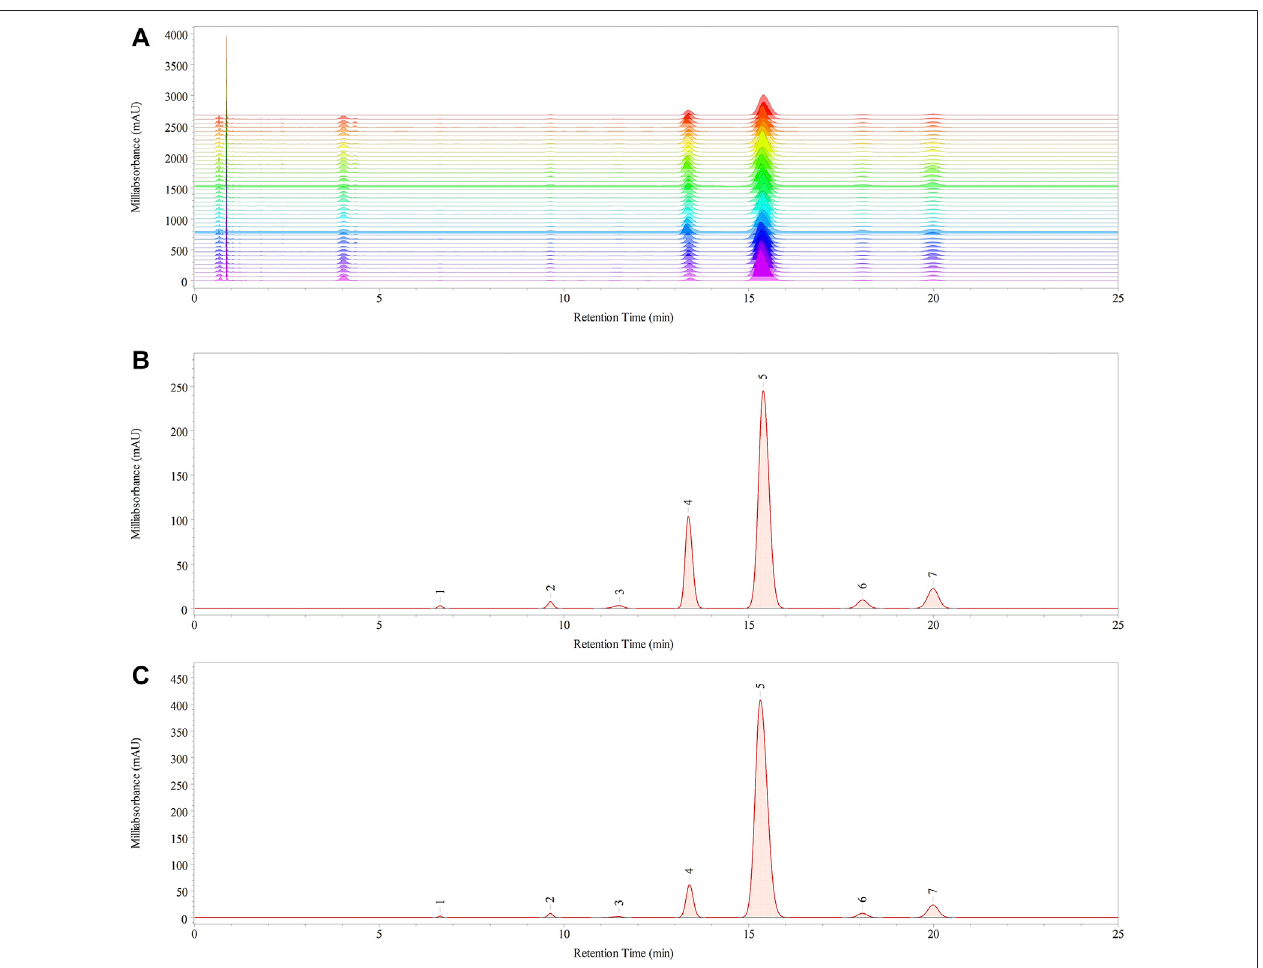
FIGURE 3 | The chromatograms of 40 polysaccharide samples (A) PCD-UPLC fi ngerprints, and the PCD-UPLC standard referential fi ngerprint of RPMPs (B) and PPMPs (C) .